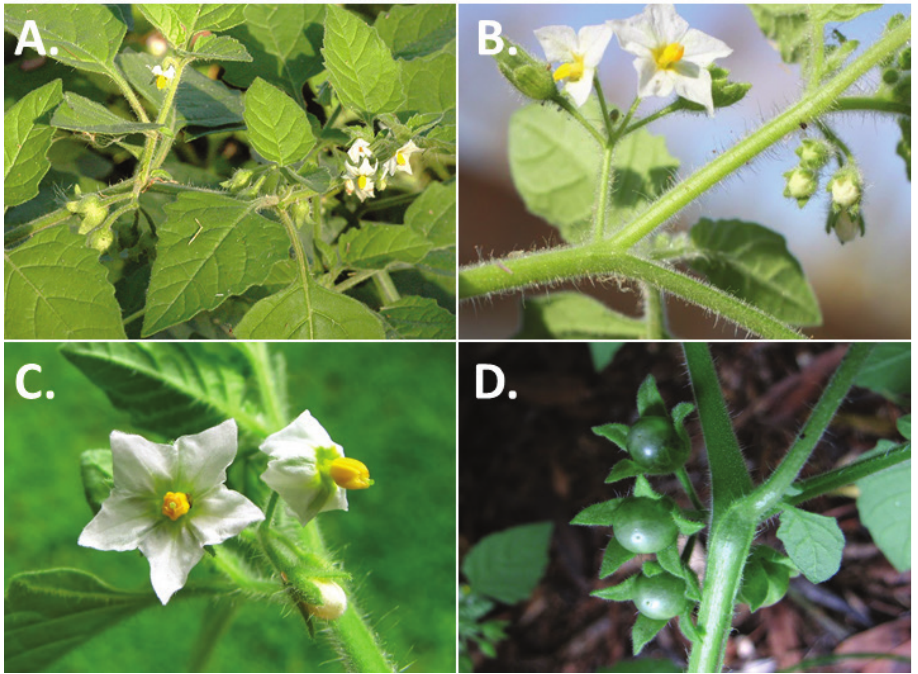
Figure 46. Solanum sarrachoides Sendtn. A Habit B inflorescence C flowers at full anthesis D developing fruits (unvouchered photos). Photos by D.G. Smith, S. Martín de la Vega, and B.W. Wells Association (previously published in “PhytoKeys